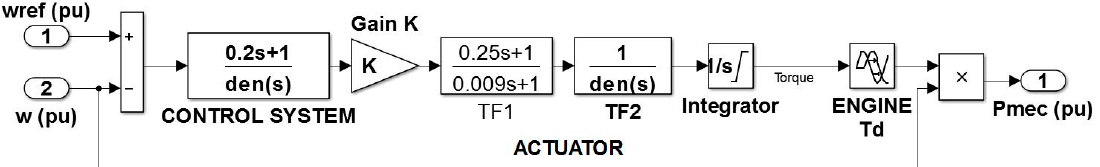
Figure 2. Governor control of the diesel generator.